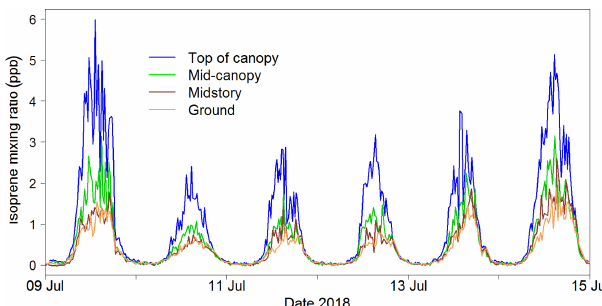
Figure 15. Portion of the isoprene mixing ratio time series mea- sured during the Wytham Woods field campaign (UK) at four heights within a forest canopy in the summer of